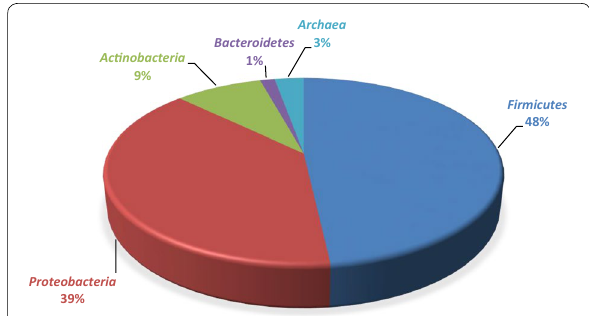
Fig. 1 Distribution of the relative abundance of the Bacteria and Archaea strains isolated at Zipaquirá salt